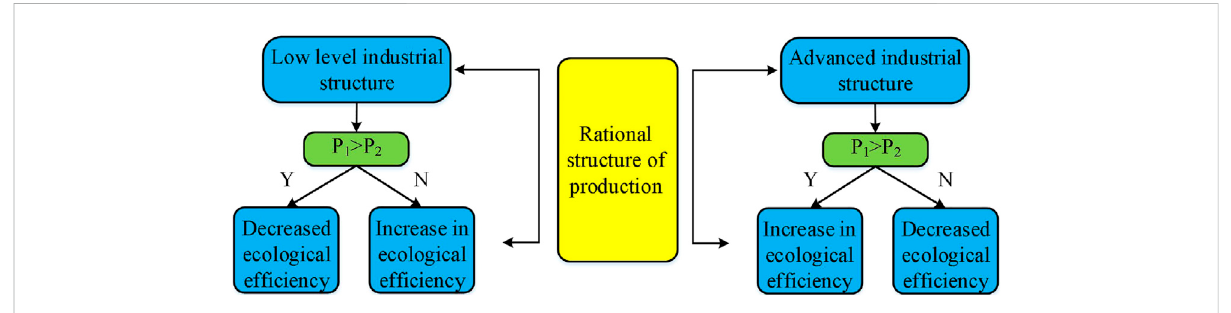
FIGURE 2 The relationship between rationalization of industrial structure and ecological ef fi ciency.